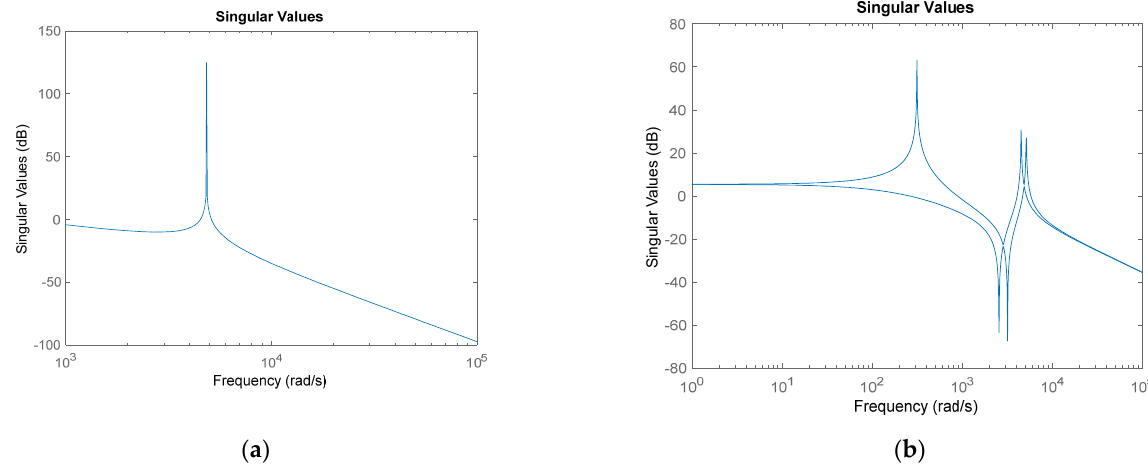
Figure 3. Frequency characteristics of ( a ) single phase LCL filter and ( b ) the system in dq frame (transfer function in (16)).